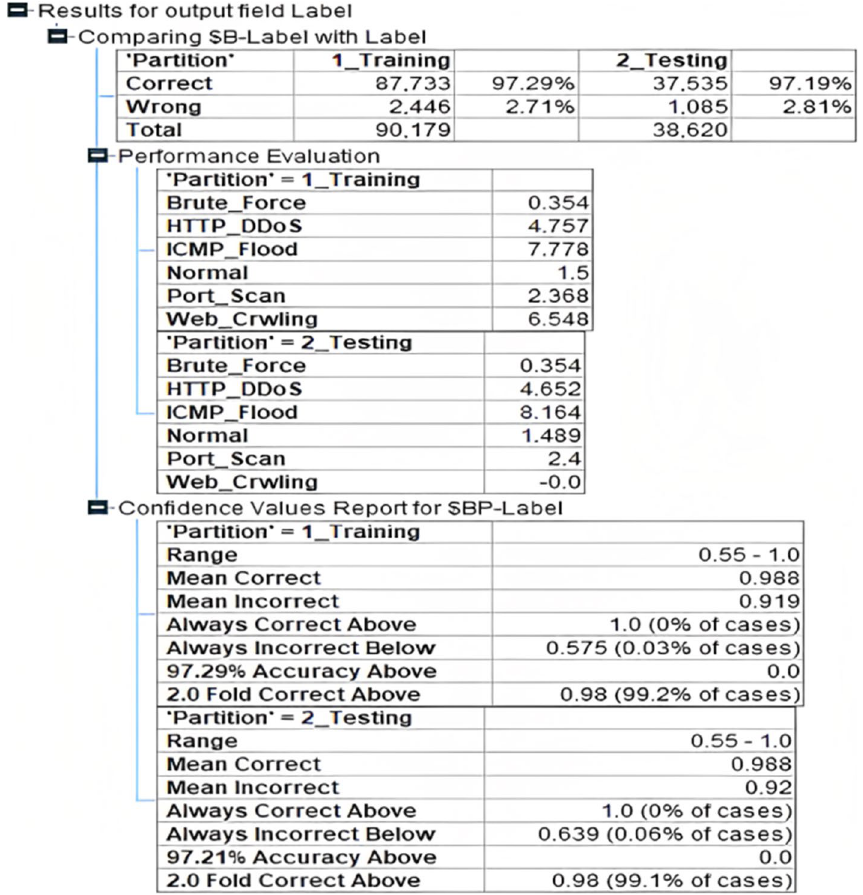
Fig. 8 Accuracy level in Bayesian